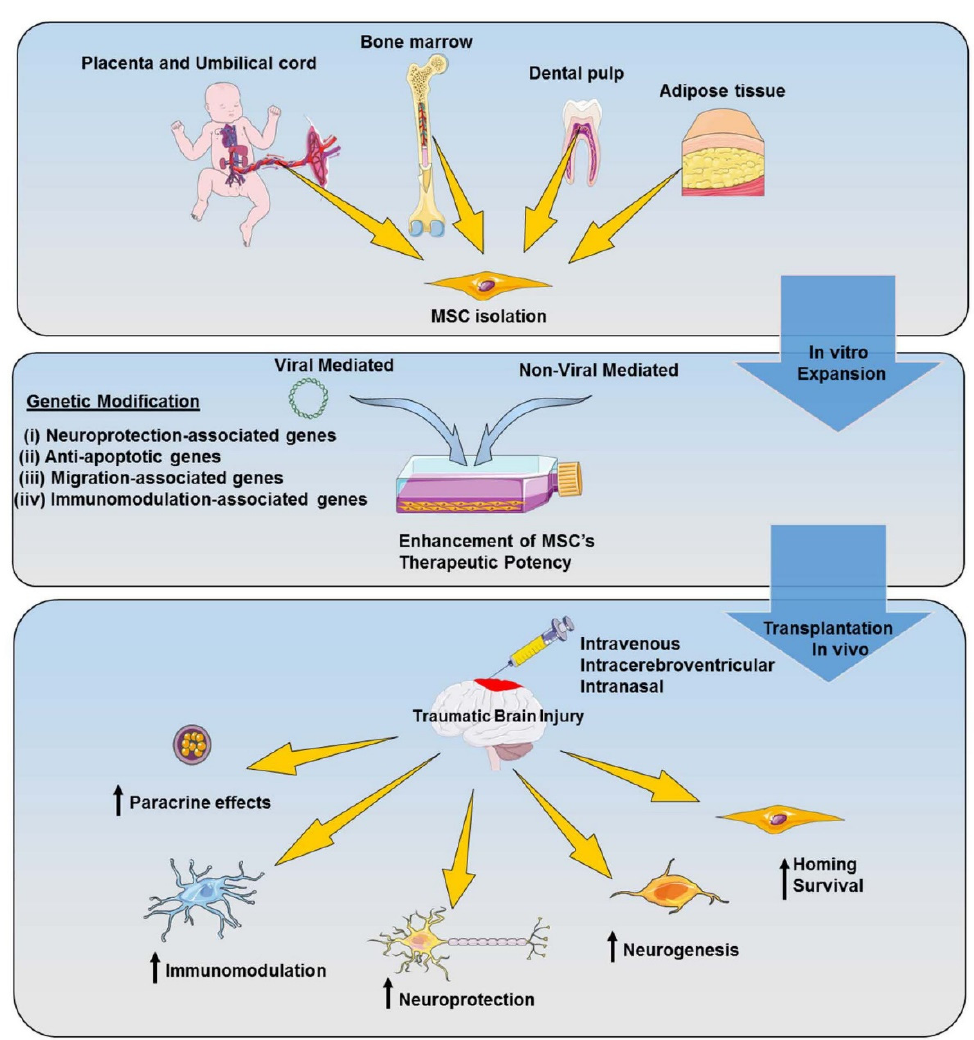
Figure 3. Improving MSCs’ therapeutic potential for TBI via genetic modification. Illustration of possible MSC sources in humans and the possible targets for genetic modification in vitro. Following transplantation, the genetically modified MSCs are able to improve the homing, survival, and paracrine e ff ects of MSCs, enhance neurogenesis, and enable neuroprotection and immunomodulation at the injury site in